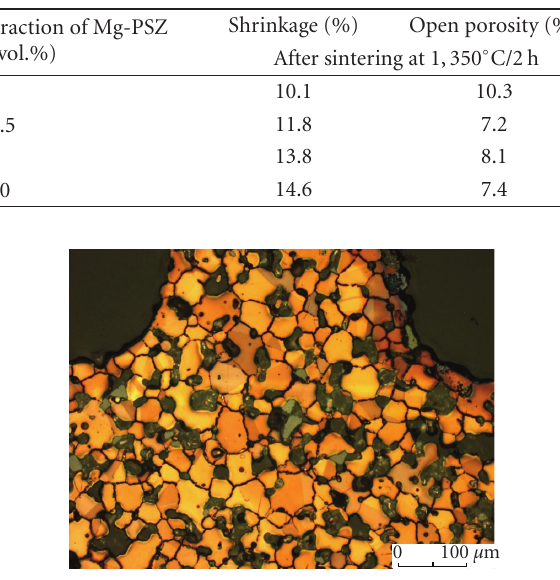
Figure 1: Microstructure inside a cell node of sintered initial state with 2.5 vol.% Mg-PSZ; Beraha II color etching, zirconia particles (grey) and pores (black) embedded in an austenite matrix (bright yellow up to brown).